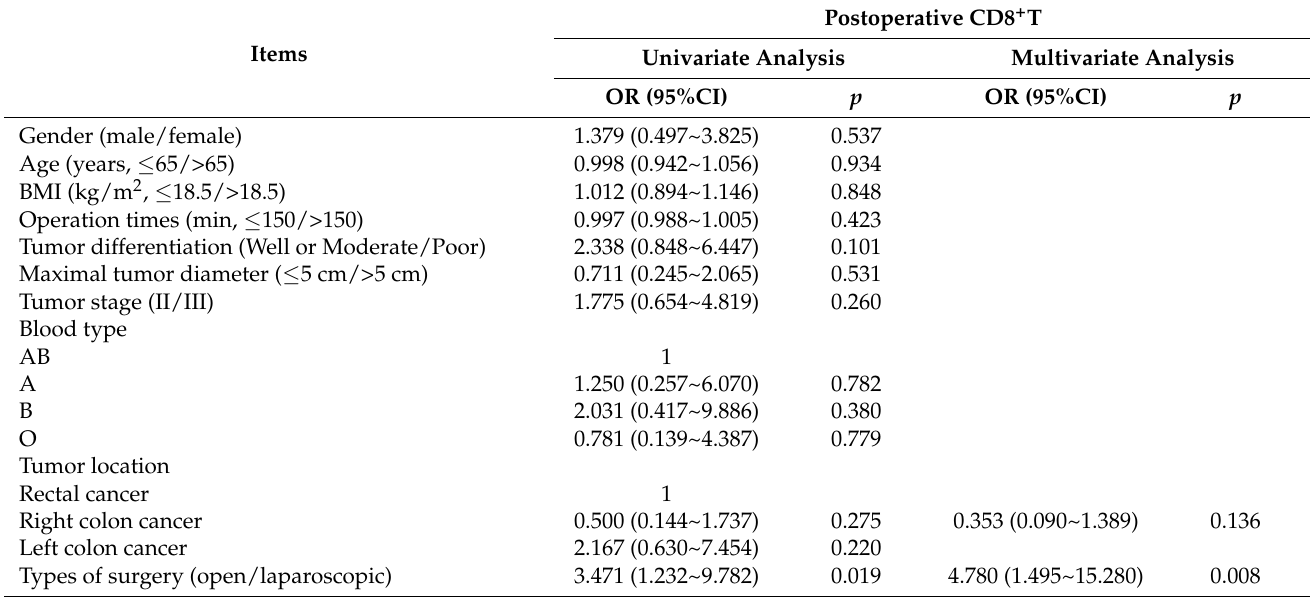
Table 5. Logistic regression analysis of the patient’s postoperative CD8 +